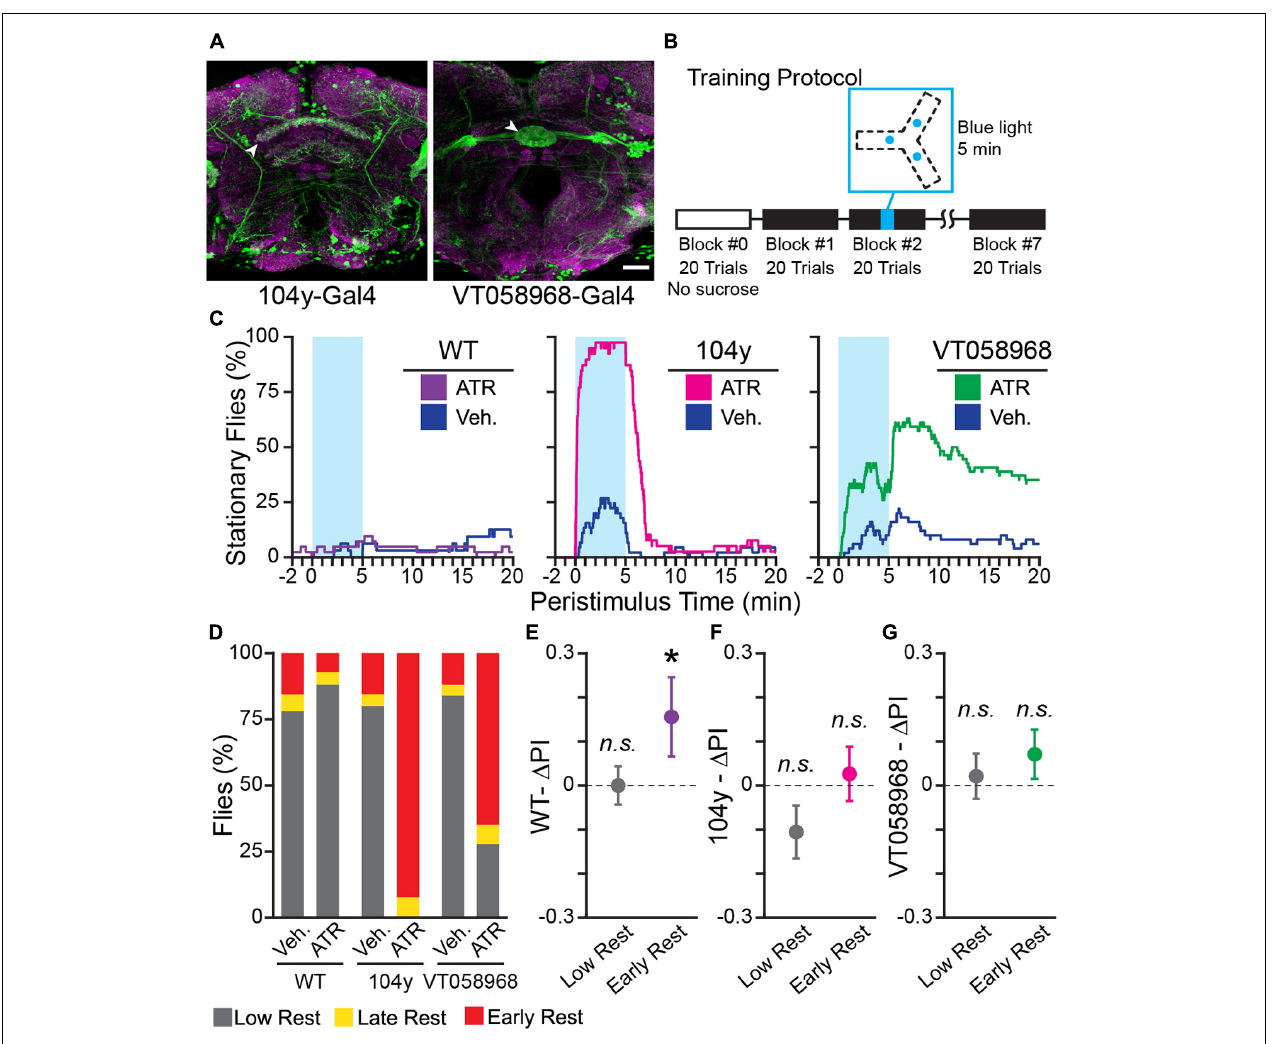
FIGURE 6 | Optogenetically-induced rest is not sufficient to enhance learning. (A) Confocal maximum intensity projections of fly brains expressing 104 y-Gal4;UAS-GFP ( left ) and VT058968-Gal4;UAS-GFP ( right ) stained for GFP ( green ) and Bruchpilot (nc82, magenta ). Scale bar is 20 µ m. White arrowheads indicate the sleep-promoting neuropil for each Gal4 driver: the dorsal Fan Shaped Body for 104 y-Gal4 and the Ellipsoid Body for VT058968-Gal4. (B) Block diagram of operant conditioning paradigm, with the time of optogenetic stimulus indicated in cyan. The track diagram indicates the locations of each blue LED in the track, these positions are equidistant from the center of the track and illuminate the entire Y-track. (C) Peri-stimulus rest plots for WT ( left ), 104 y ( center ), and VT058968 ( right ). Blue shaded area shows when the blue LED is on. The plots show 20 min of behavior following light onset—this time is not linked to trial times, which vary between animals, and does not encompass the entire duration of the experiment. (D) Percent of each rest phenotype present in each experiment group. (E–G) Results of training WT (E) , 104 y (F) , and VT058968 (G) flies. Early and low rest flies for each genotype were pooled from the ATR and vehicle groups. Change in PI ( (cid:49) PI) is plotted for each genotype; colorful points are flies with early rest ( purple: WT, magenta : 104 y, green : VT058968). Error bars are standard error of the mean, n.s. : groups are not significantly greater than zero, * groups are significantly greater than